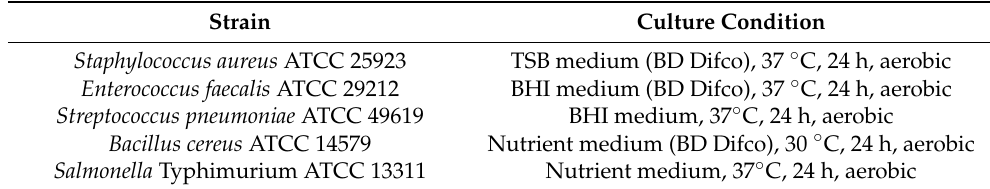
Table 2. Pathogenic bacteria used in this